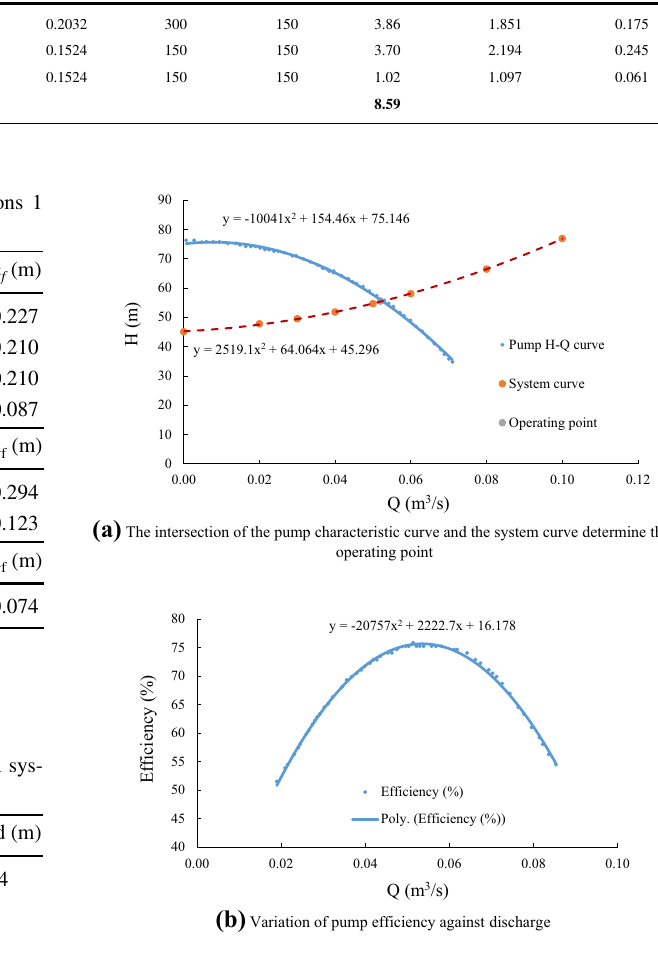
Table 1 Friction loss ( h main pipe between stations 1 and 4